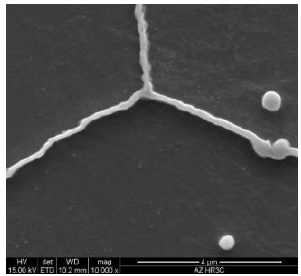
Figure 7. Widening of grain boundaries in HR3C steel after service.